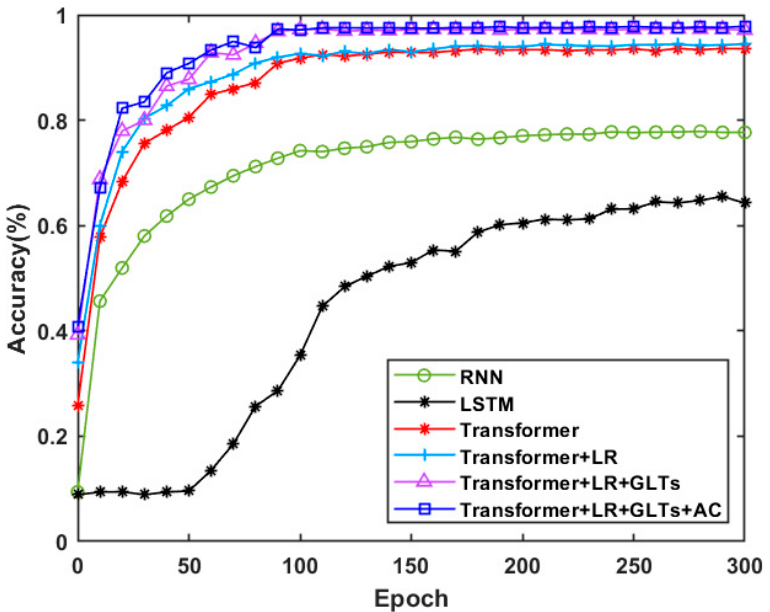
Figure 6. Relationship between recognition accuracy and epoch.